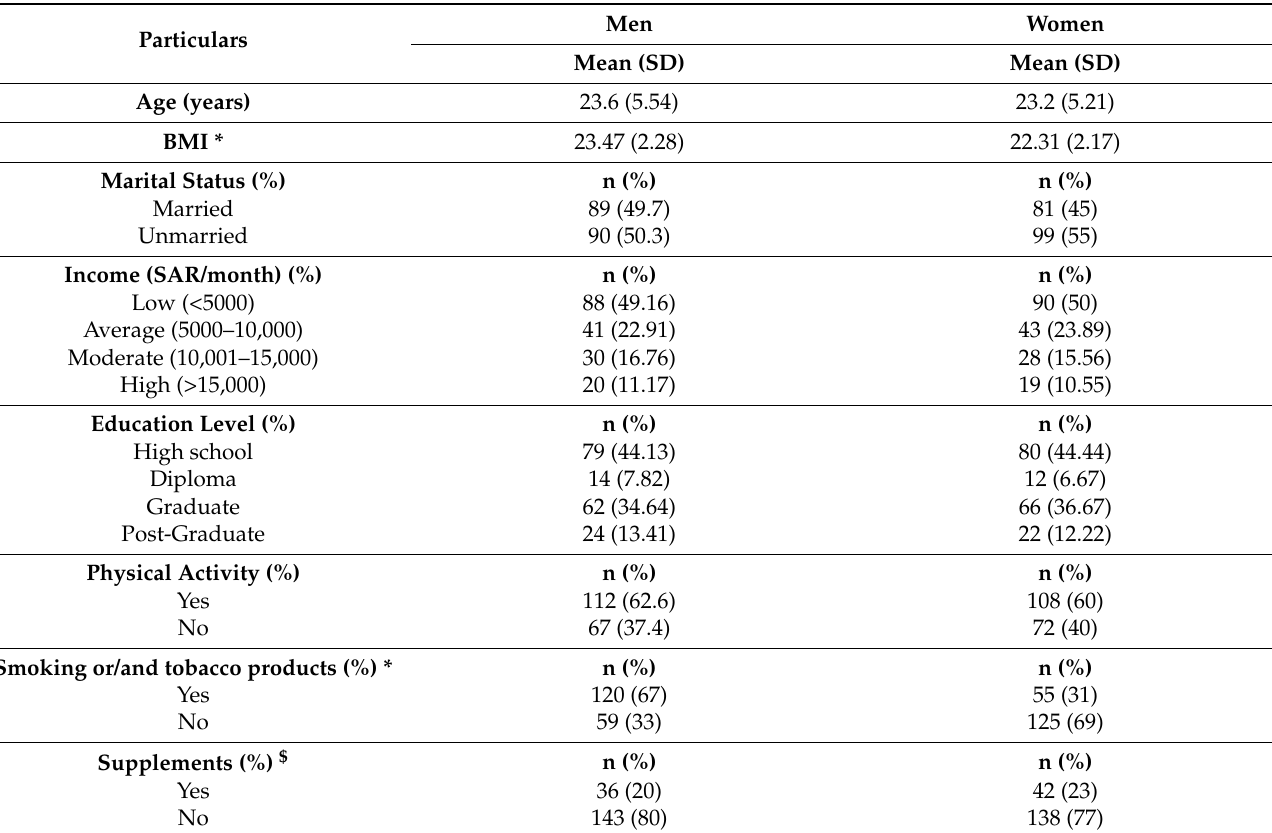
Table 1. Characteristics of demographic, anthropometric, mood test and food consumption by gender of the total study